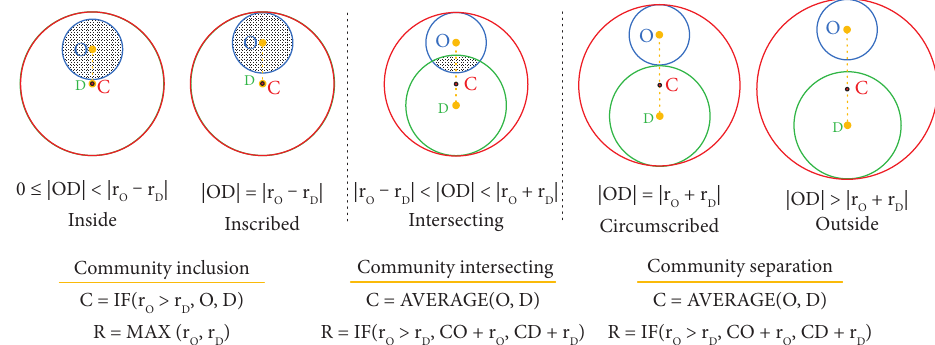
Figure 4: Schematic diagram of three community situations. Note. The blue circle represents the taxi pick-up community, its center is O, and its radius is r O . The green circle represents the taxi drop-off community, its center is D , and its radius is r D . The red circle represents the smallest circumscribed circle that contains two communities, its center is C, and its radius is R. In the case of community inclusion, if r O > r D , then C is O; otherwise, C is D. The value of R is maximum in r O and r D . In the case of community intersection or community separation, the value of C is average of O and D coordinates. If r O > r D , then the value of R is the sum of the values of CO (distance value between C and O) and r O ; otherwise, the value of R is the sum of the values of CD (distance value between C and D) and r O .